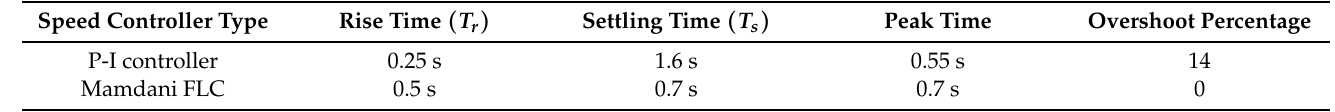
Table 2. Performance comparison between P-I controller and Mamdani fuzzy logic controller (cid:1) speed transition